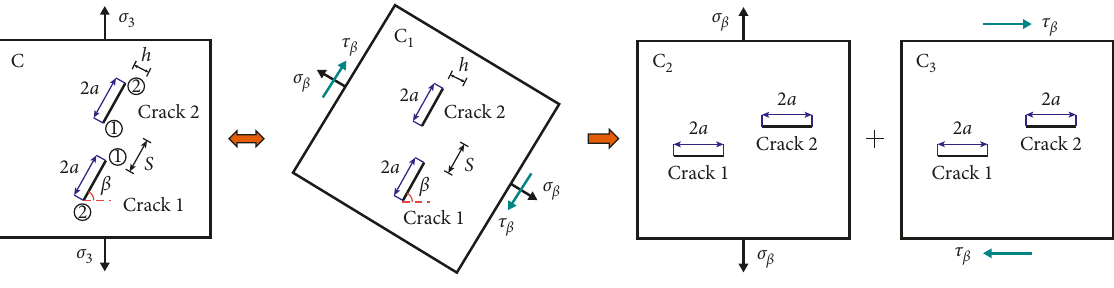
Figure 4: Equivalent sketch of the stress state (C) of rock mass under uniaxial tension.